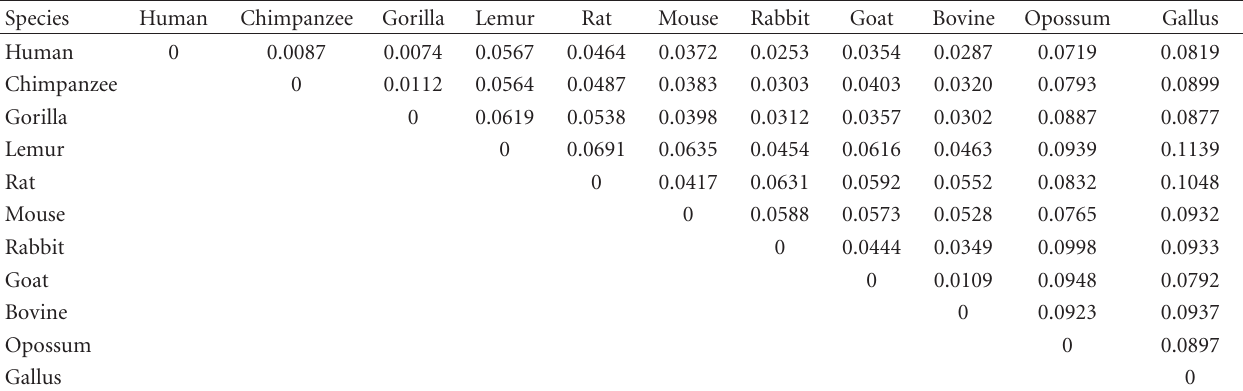
Table 4: The upper triangular part of the dissimilarity/similarity matrix based on d 2